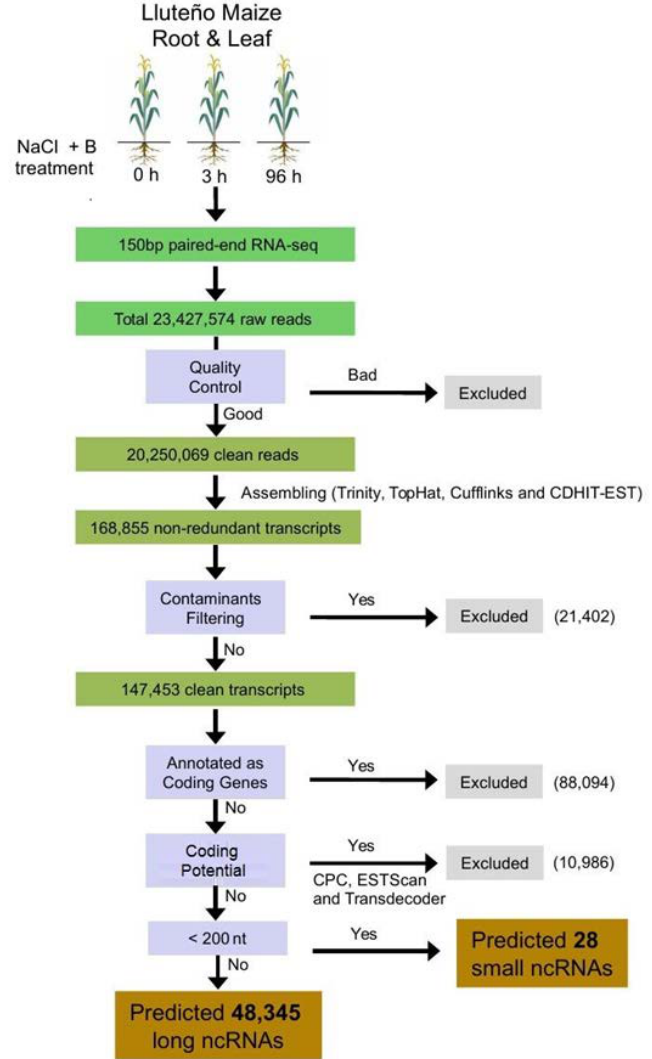
Figure 2. General flowchart of the pipeline used to identify the repertoire of long non-coding RNAs (lncRNAs) from Lluteño maize expressed under to salt and boron stress conditions. RNA-seq: RNA sequencing.